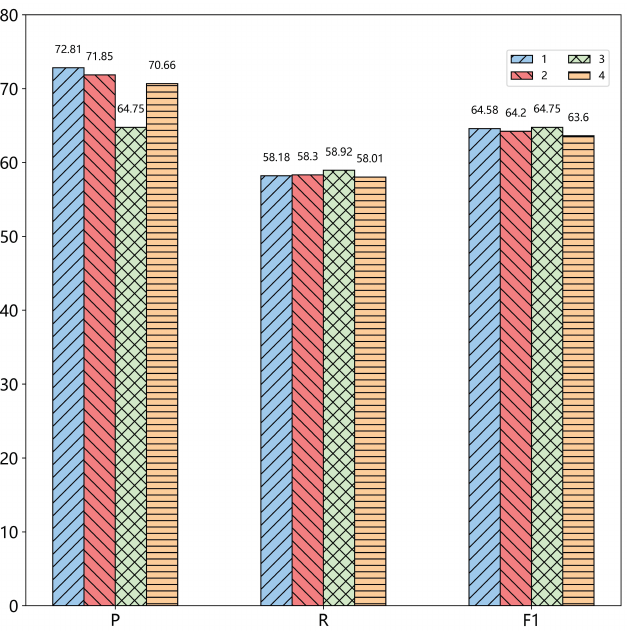
Figure 4. Precision, recall, and F1 value variation of ECPE tasks across different